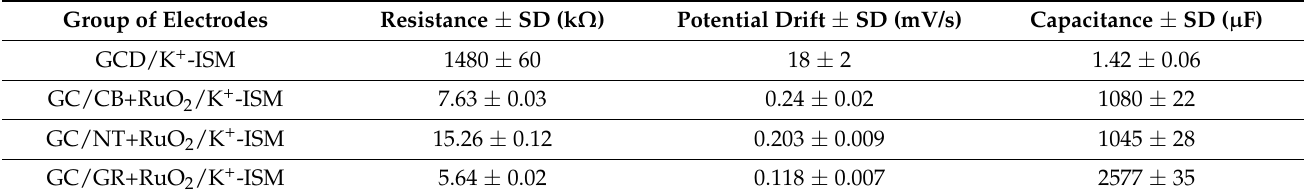
Table 1. Electrical parameters of studied electrodes ( n = 3) obtained from the chronopotentiometric measurements.